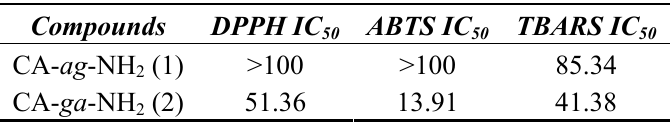
Table 3. DPPH, ABTS, and TBARS IC values, defined as the compound amount causing 50 per cent activity inhibition, was determined from the plotted